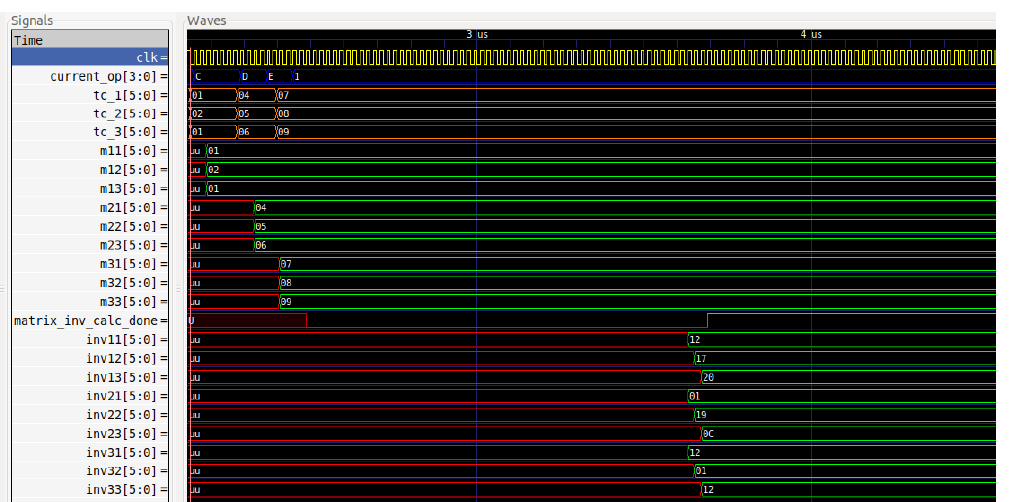
Figure 8. The modular inverse calculation of the asymmetric key.